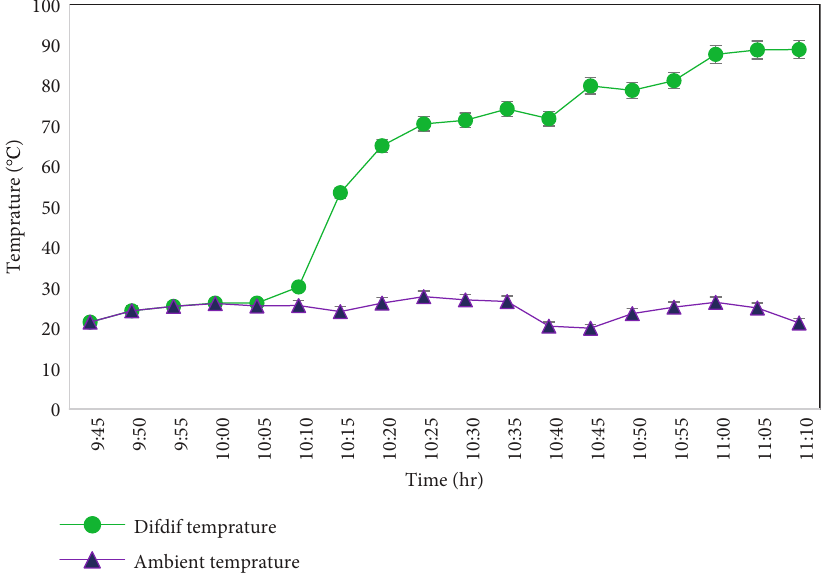
Figure 7: “ Difdif ” temperature distribution and ambient